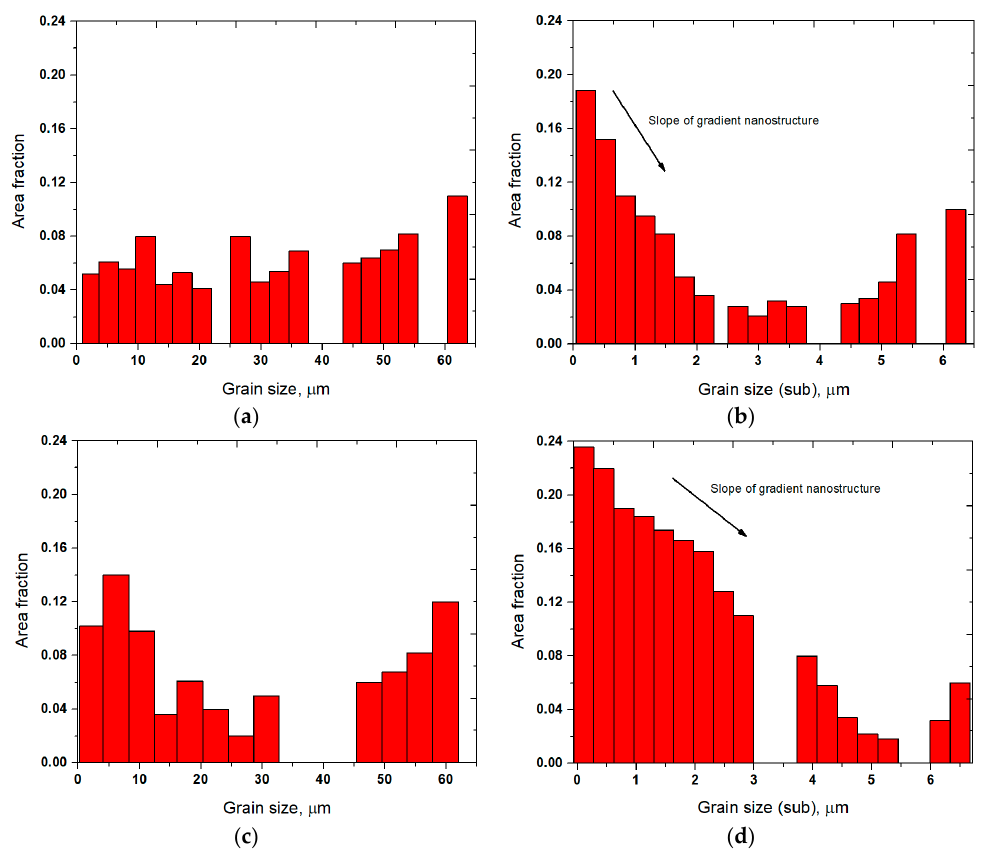
Figure 2. Histogram of the grain size distribution of the untreated ( a ), UNSM-treated at RT ( b ) and LHT without ( c ) and with ( d ) UNSM treatment at 1000 °C specimens representing the presence of gradient nanostructured surface